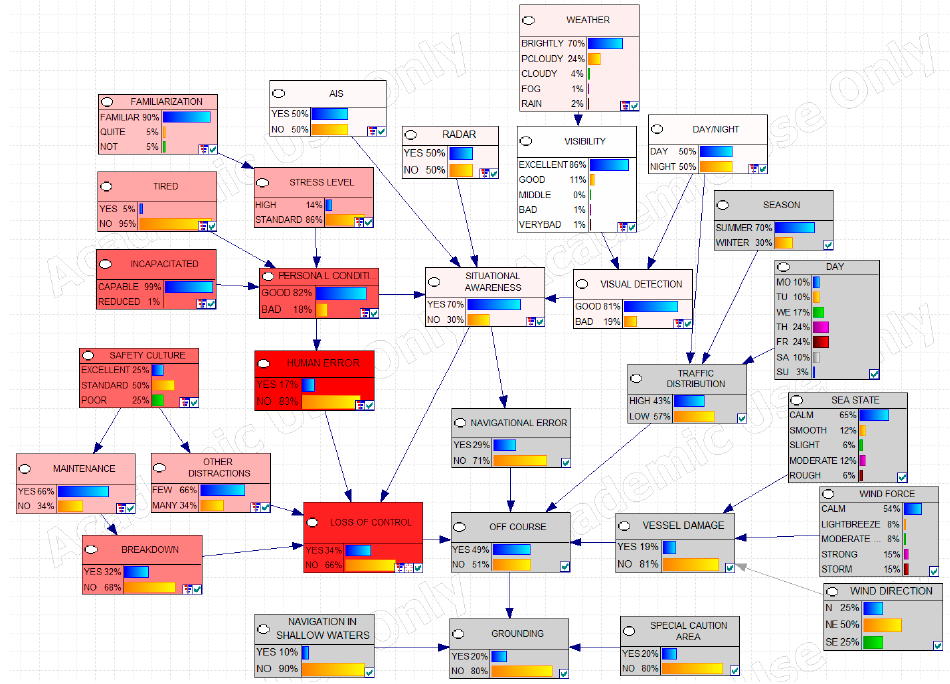
Figure 6. Sensitivity analysis for the grounding model when targeting “loss of control”.